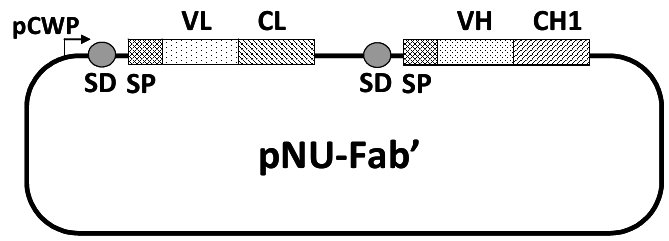
Figure 6. Structure of the expression/secretion vector, pNU-Fab’. pCWP, the promoter of the B. brevis cell wall protein gene operon; SD, the ribosome binding site of the middle wall protein gene; SP, the signal peptide of the MWP; VL, the variable domain of the light chain; CL, the constant domain of the light chain; VH, the variable domain of the heavy chain; CH1, the first constant domain of the heavy chain. VL and VH are those from the mouse anti-(urokinase-type plasminogen activator) IgG gene, whereas CL and CH1 are from the human IgG